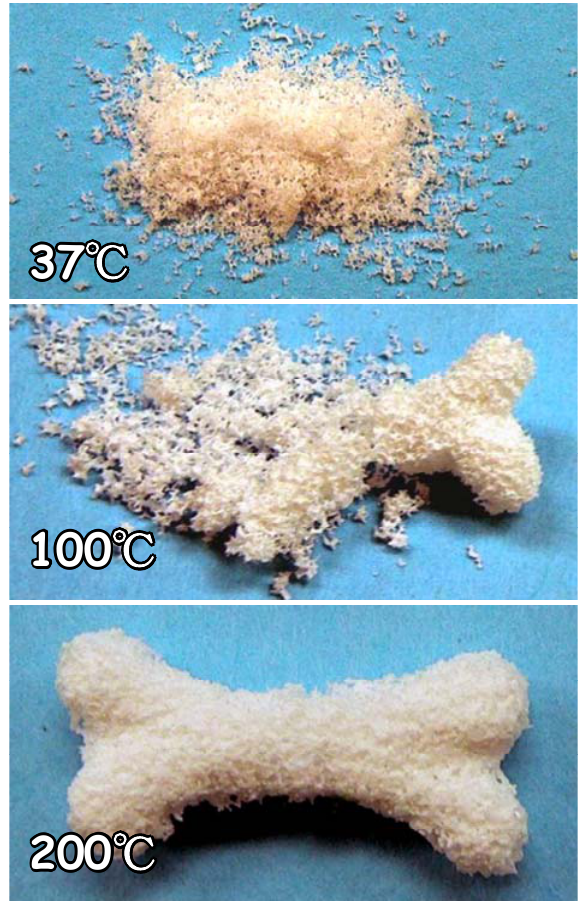
Figure 12. Photographs of specimens of α -TCP foam granules after immersion at 37 °C (top) and after hydrothermal treatment at 100 °C (middle) and 200 °C (bottom) for 24 h